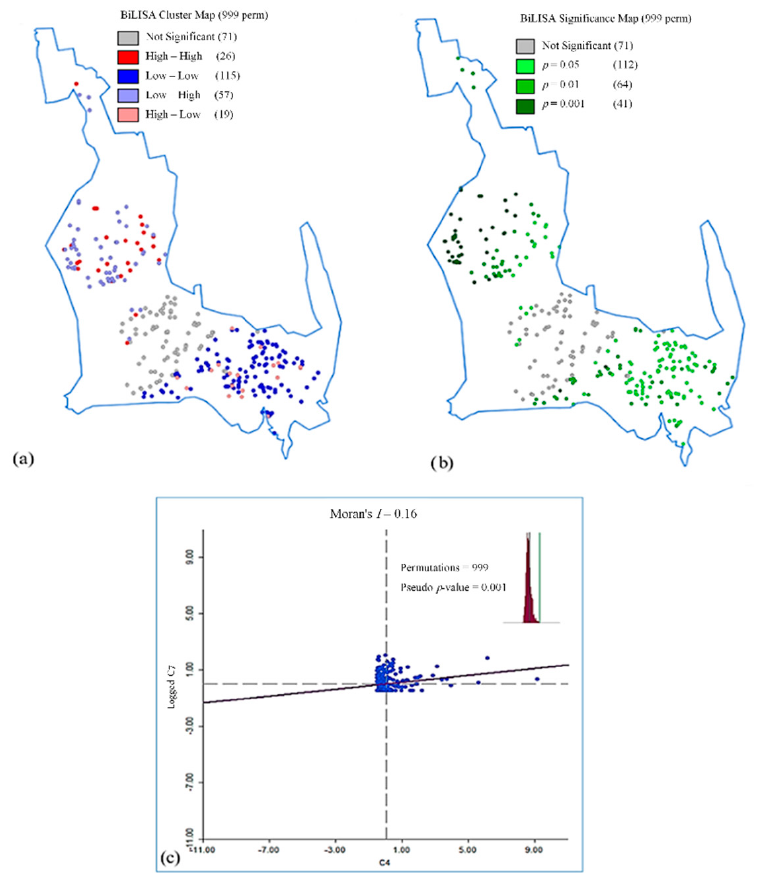
Figure 6. BiLISA ( a ) clustering and ( b ) significance maps, for total date trees number plotted against total cultivated area, examined by ( c ) Moran’s I .